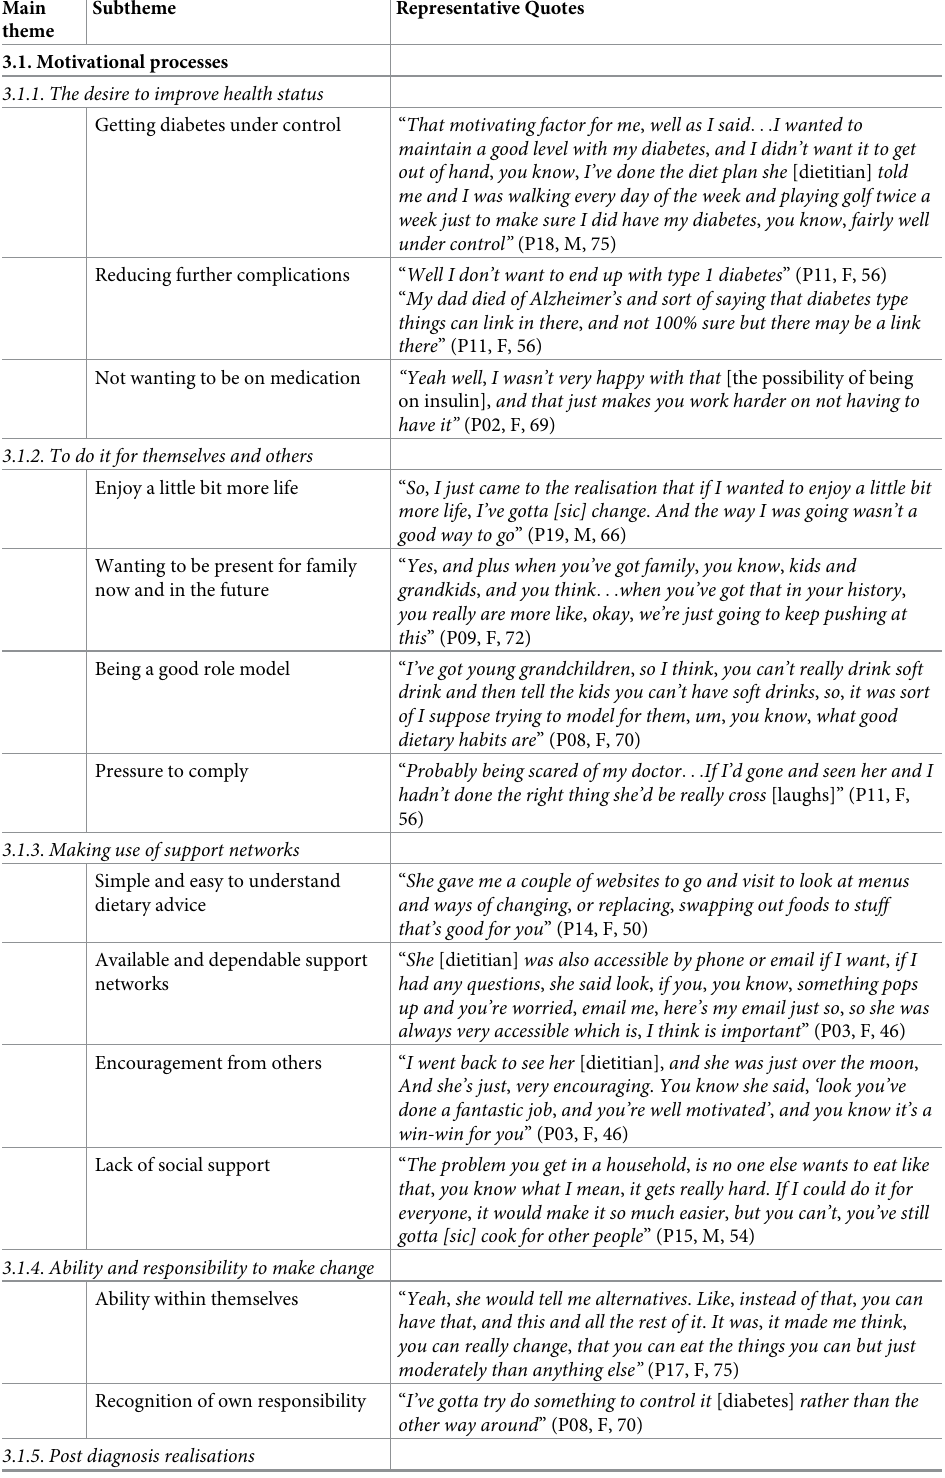
Table 1. List of the 15 themes, accompanying subthemes and representative participant quotes, for a qualitative study exploring the decision-making processes of dietary behaviour change after a diagnosis of type 2